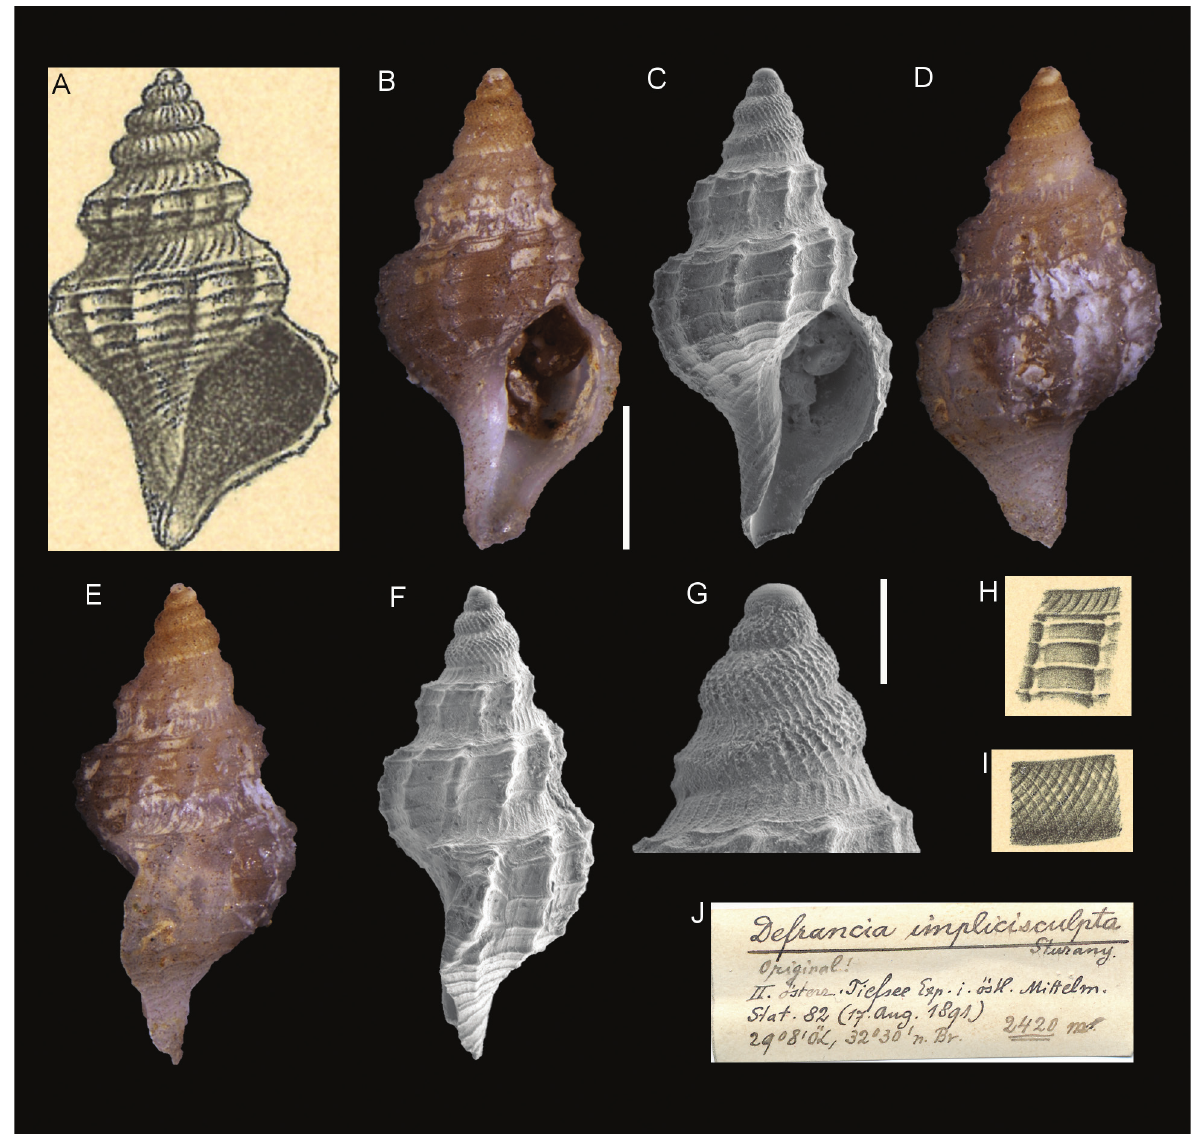
Figure 7. Defrancia implicisculpta, Sturany, 1896, station 82, north of Alexandria, Egypt, 2420 m. A , H , I . Original figures in Sturany, 1896. B–G . Holotype NHMW 13003: front ( B–C ), back ( D ), side ( E – F ) views and microsculpture ( G ). J . Original label. Scale bars: 1 mm ( B–F ), 0.3 mm ( G